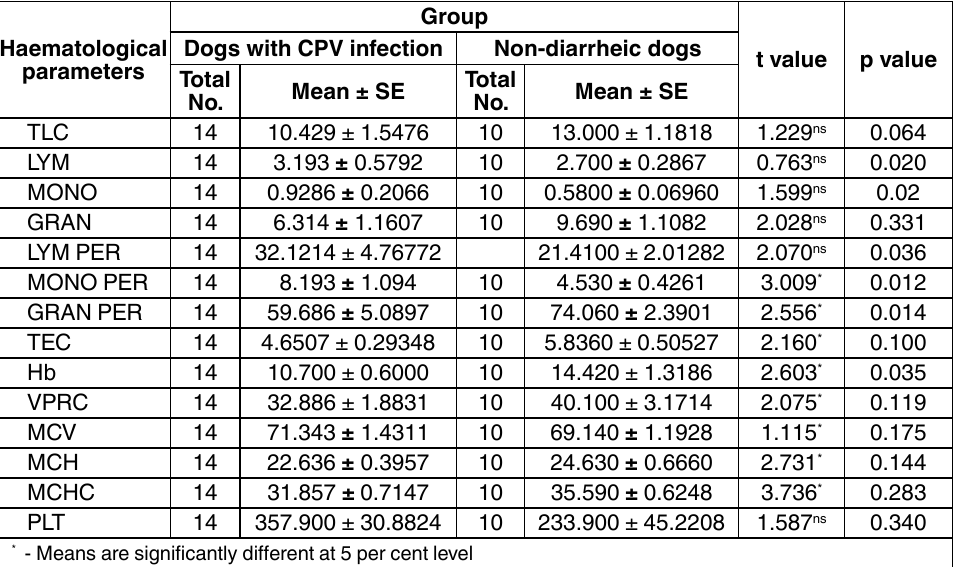
table 8. Comparison between haematological values of CPV infected and control dogs haematological parameters